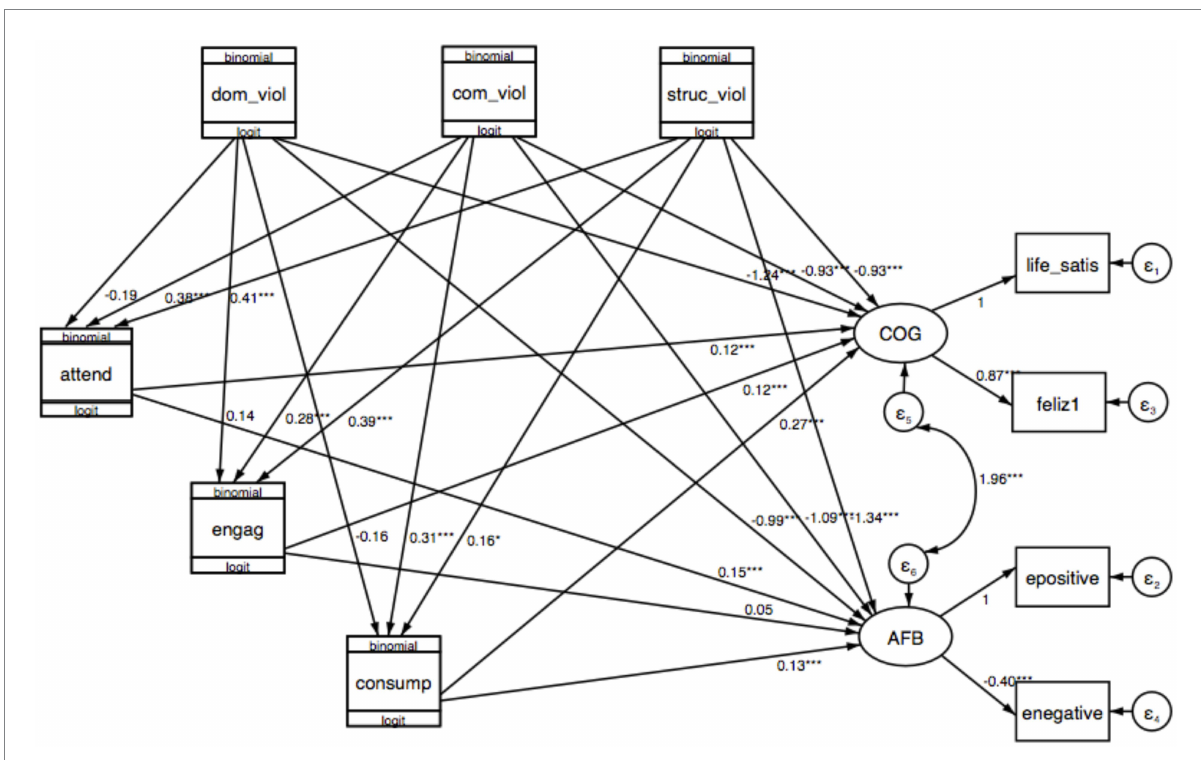
FIGURE 4 Final statistical model, unstandardized coefficients a . a, Interaction terms are not included; atten, Attendance; engag, Engagement; consump, Consumption; dom_viol, Domestic violence; com_viol, Community violence; struc_viol, Structural violence; life_satis, Life satisfaction; feliz, Happiness; epositive, Positive emotions; enegative, Negative emotions; COG, Cognitive well-being; AFB, Affective balance. * p < 0.05, ** p < 0.01, *** p <